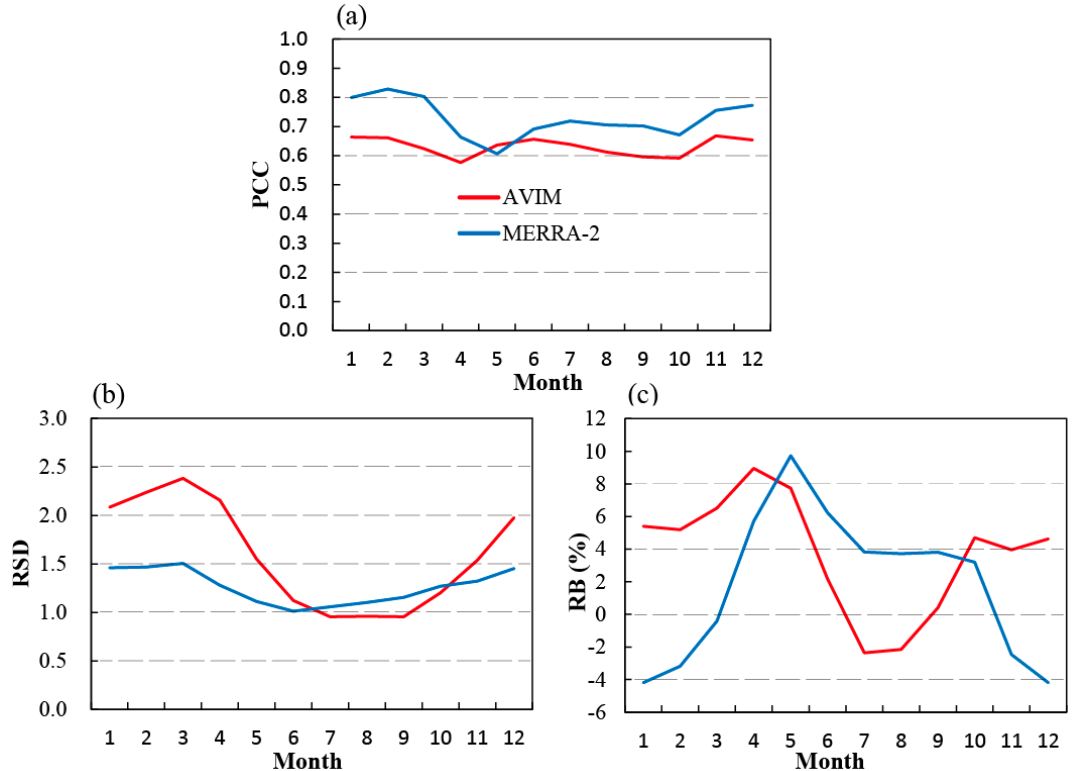
Figure 4. Monthly PCC ( a ), RSD ( b ), and RB ( c ) of the surface soil moisture in the AVIM and MERRA-2 datasets with the CCI dataset as a reference. The statistics were calculated based on mean annual monthly global data.